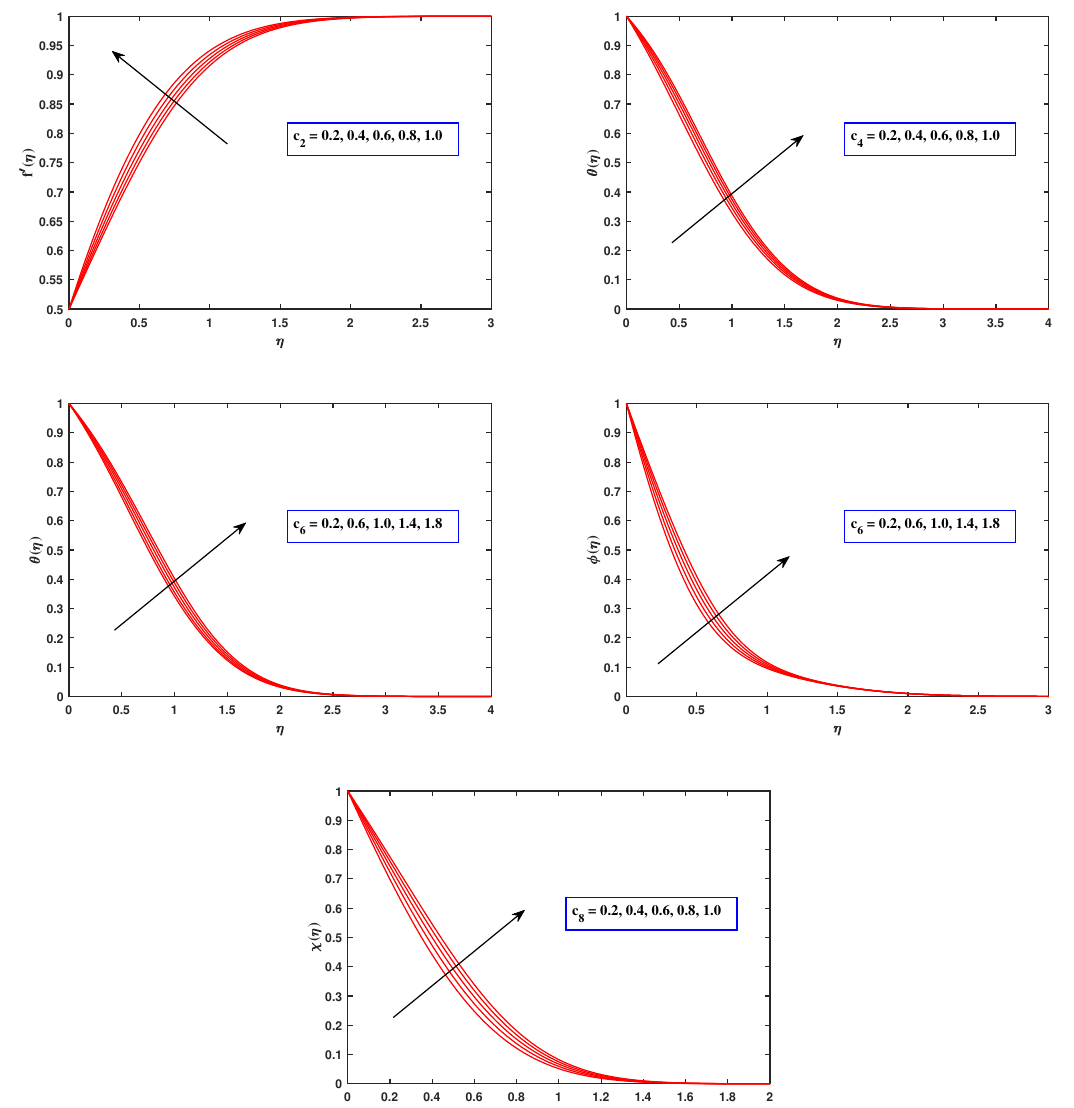
Figure 3. Fluctuation in profiles (velocity, temperature, concentration and motile density) with concentration dependent